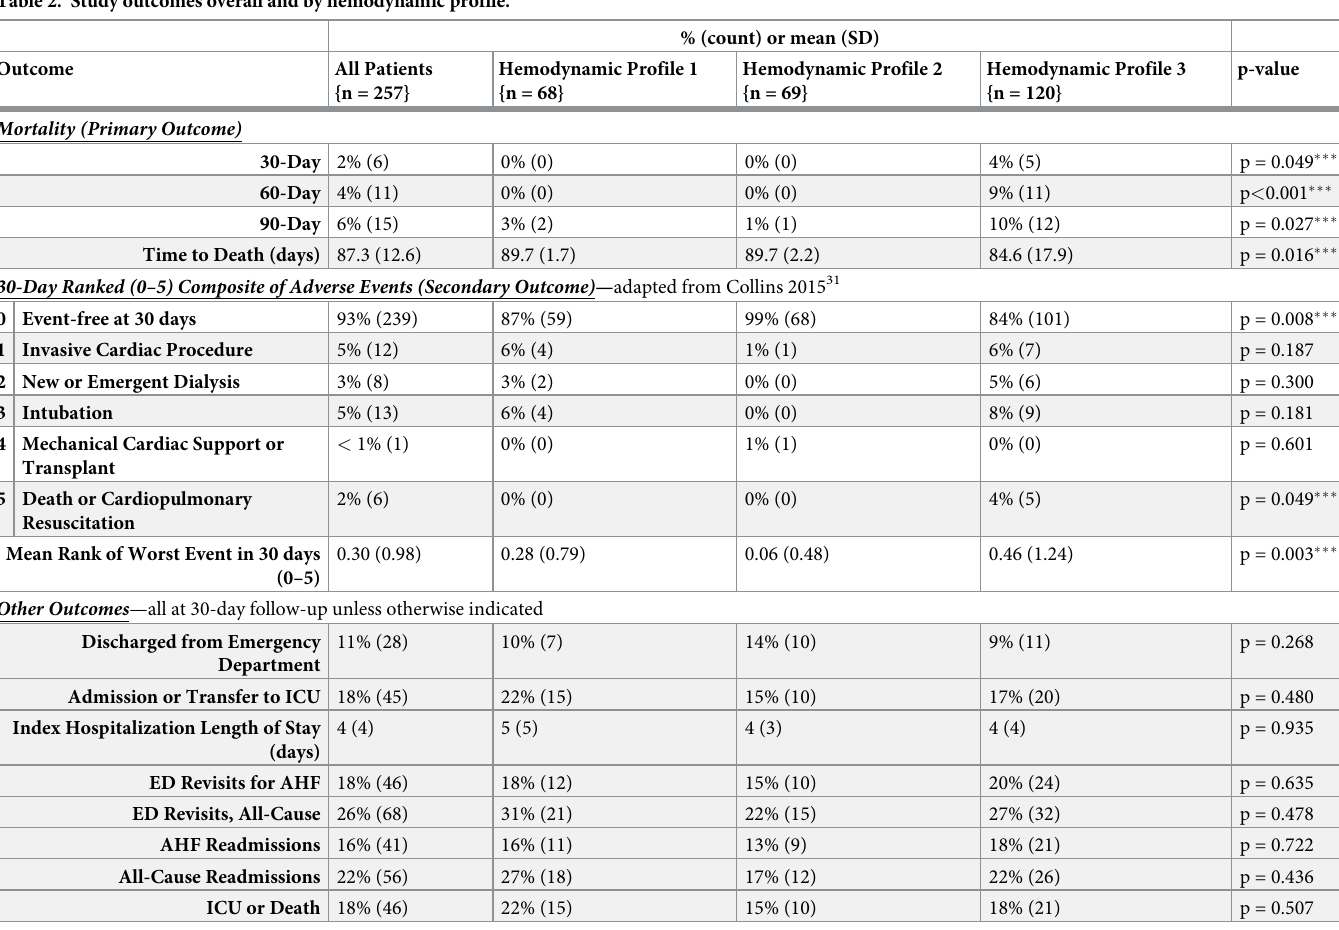
Table 2. Study outcomes overall and by hemodynamic profile.